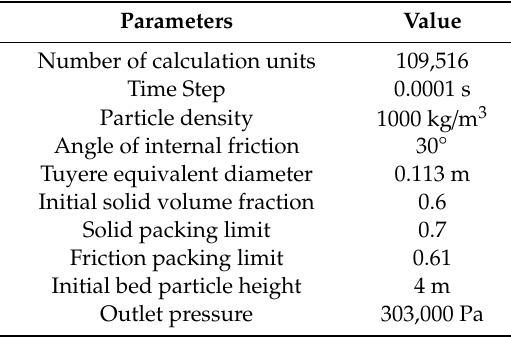
Table 3. Simulation parameters.